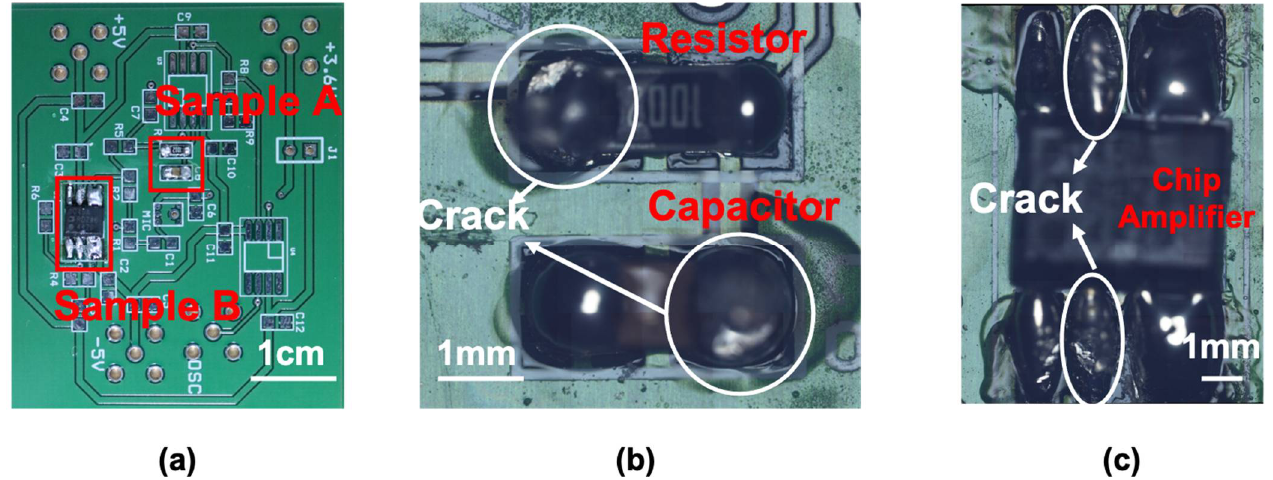
Figure 4. Specimen: ( b ) sample A (resistor and capacitor) and ( c ) sample B (AD8045 chip amplifier).